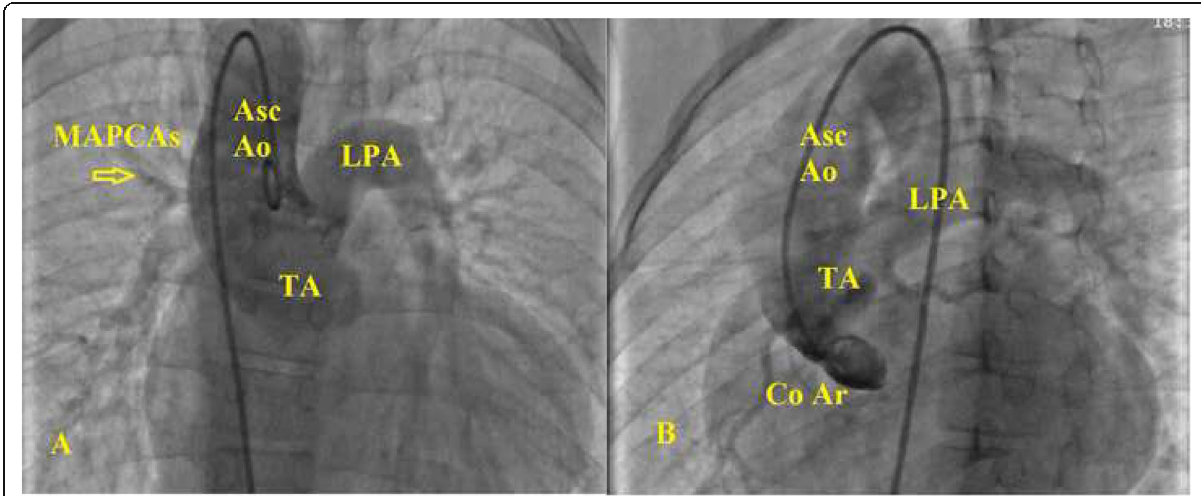
Fig. 1 Cardiac catheterization study. a Antero-posterior view. b Lateral view. TA, truncus arteriosus, the common arterial trunk; Asc Ao, ascending aorta; LPA, left pulmonary artery; MAPCAs, major aorto-pulmonary collateral arteries; Co Ar, coronary artery; The aorta, left pulmonary artery, and coronary artery, all arising from the common arterial trunk, the truncus